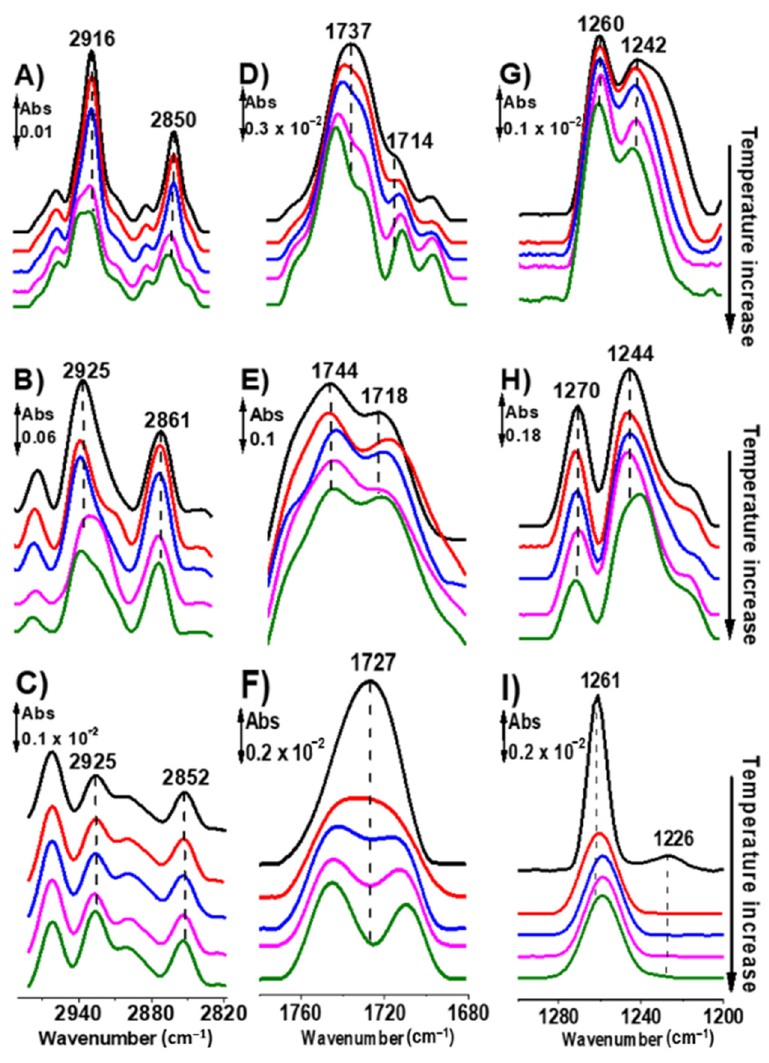
Figure 4. ( A , D , G ) Absorbance FTIR spectra of the temperature dependence of the lipids immobi- lized on a gold layer, ( B , E , H ) on the nanoantennas and ( C , F , I ) on gold nanoparticles. The spectra shown in each panel were obtained from 25 °C (top spectrum) to 75 °C (bottom spectrum): 25 °C (black line), 35 °C (red line), 45 °C (blue line), 55 °C (magenta line) and 75° (olive line). The panels show the spectroscopic changes occurring in the ν s, as (CH 2 ) ( A – C ), the ν (C=O) ( D – F ) and the ν as (PO 2 − ) ( G – I ) bands.